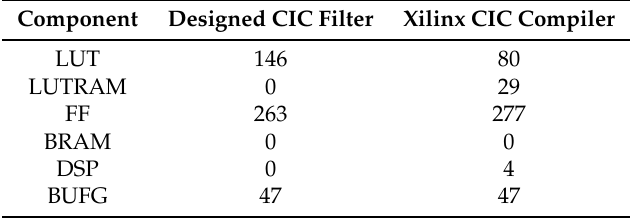
Table 4. Resource-utilization comparison. Designed Cascaded Integrator Comb (CIC) Filter vs. IP core.